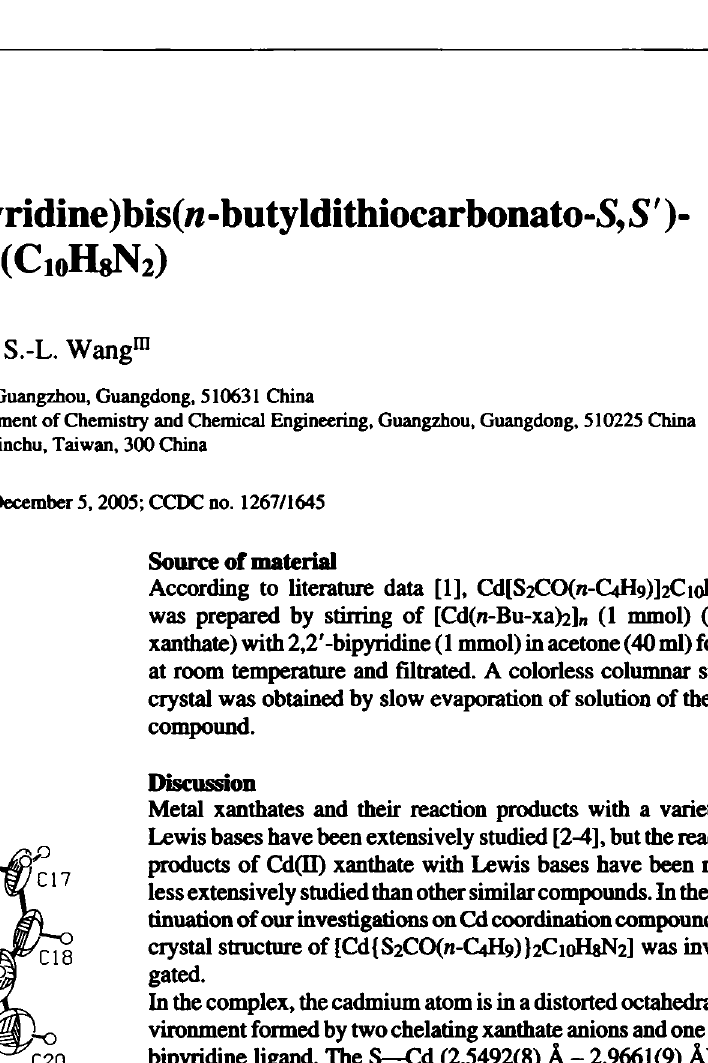
Table 1. Data collection and handling.